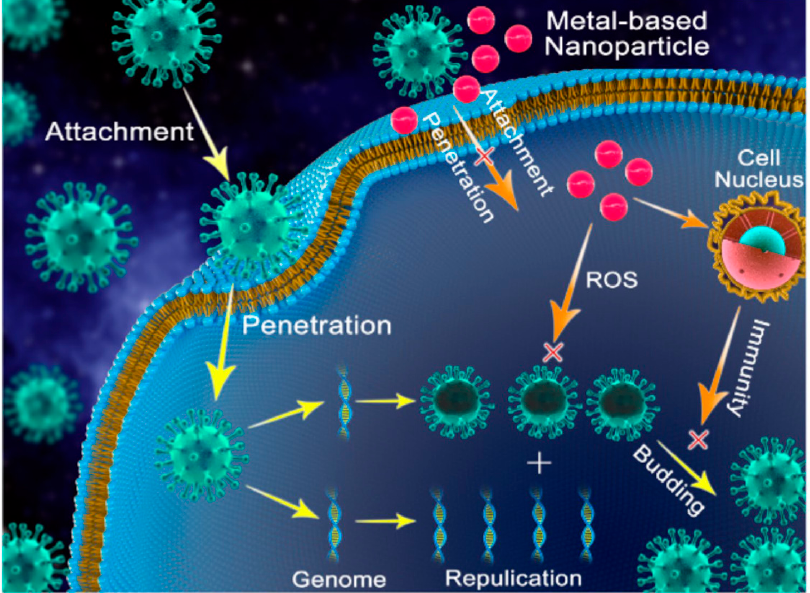
Figure 8. Possible antiviral mechanism of metal NPs. Reproduced with permission from Reference [103]. Copyright 2020, Springer